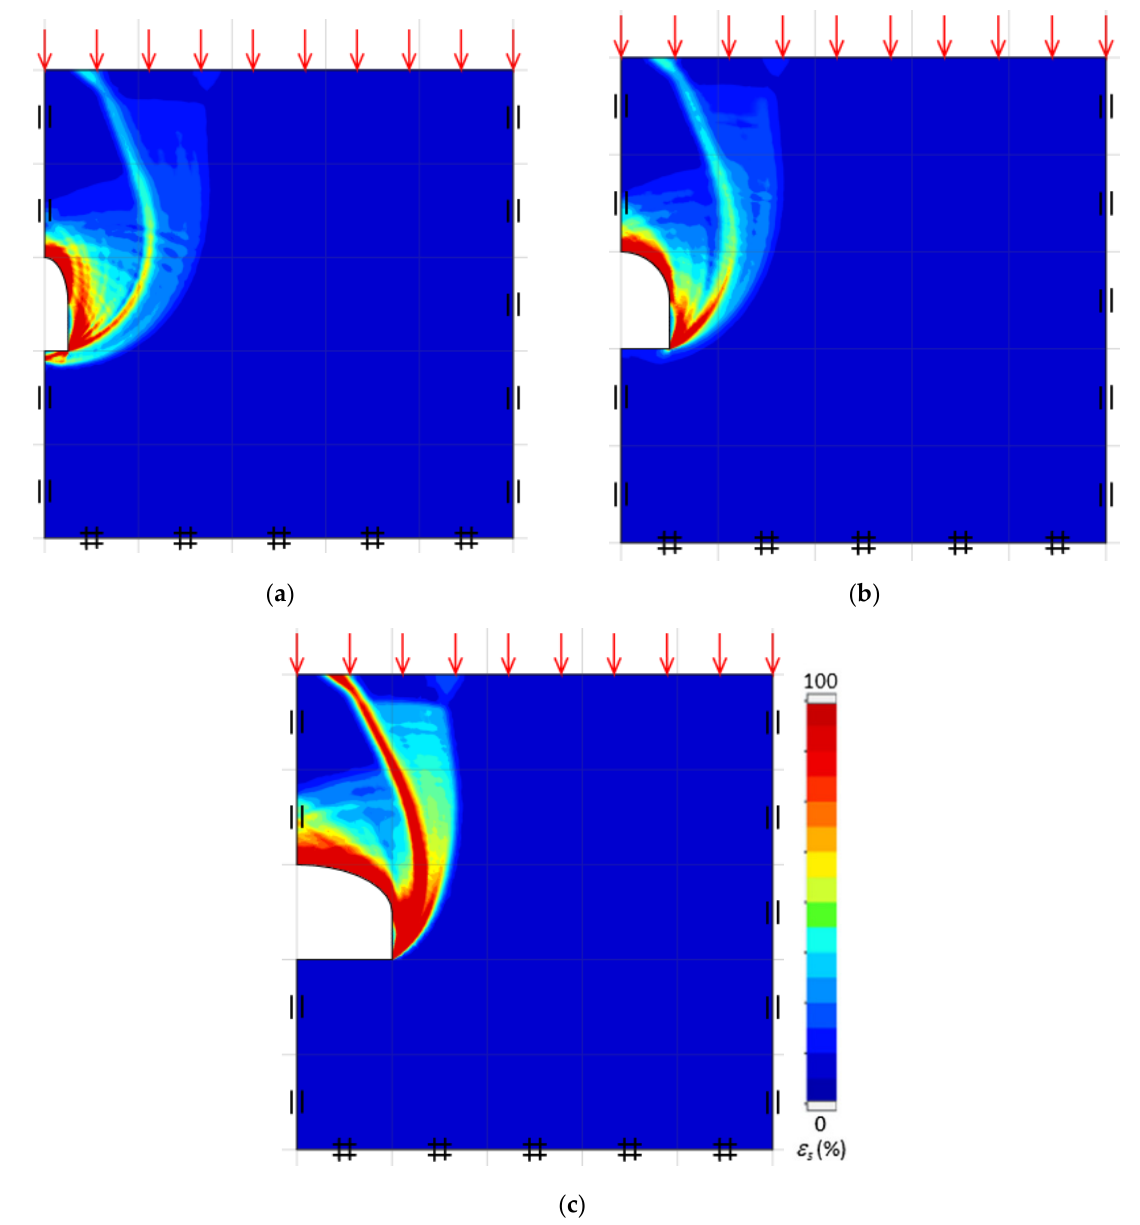
Figure 10. Shear dissipations of horseshoe tunnel: ( a ) B / D = 0.5, ( b ) B / D = 1 and ( c ) B / D = 2 ( GSI = 80, C / D = 2, σ ci / γ D = 1000, and m i = 20). Figure 11 presents the failure mechanisms for the four GSI values while the plots in Figure 12 are for four different m i values. The chosen cases for Figure 11 are ( C / D = 2, B / D = 0.5, σ ci / γ D = 1000, m i = 20, and GSI = 40, 60, 80, and 100), whereas Figure 12 shows the cases of ( C / D = 2, B / D = 2, σ ci / γ D = 1000, GSI = 80, and m i = 5, 10, 20, 30). From both figures, it can be concluded that the influence of the GSI and m i on the overall failure mechanisms is negligible, given the uniform surcharge pressures at the collapse state. The absolute values of shear dissipation are not significant; hence, they are not shown in the